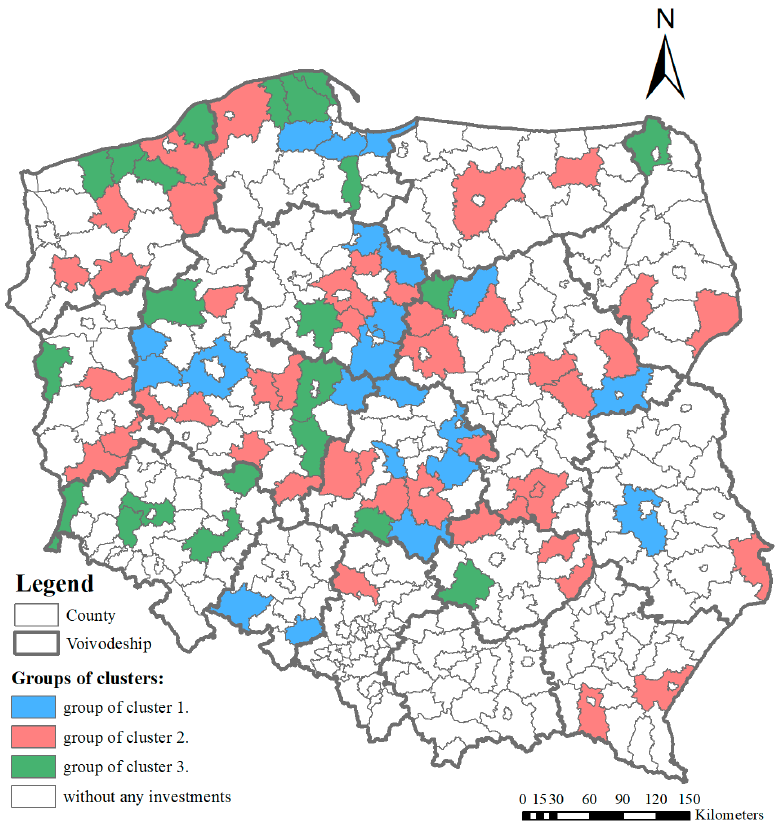
Figure 6. Spatial distribution of wind energy clusters.